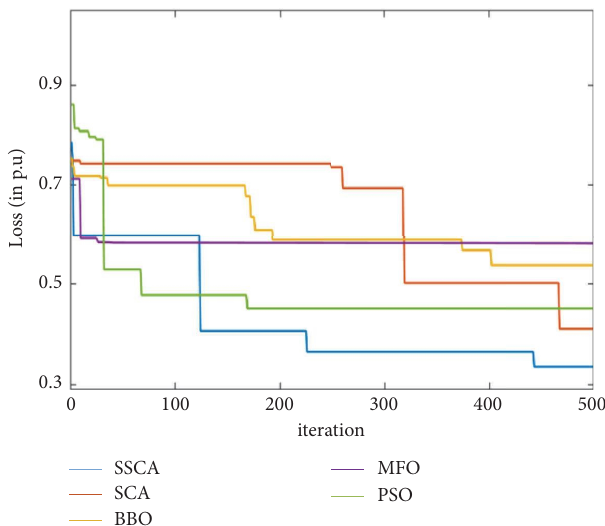
Figure 8: Loss variation in the IEEE-57 bus system at 125% loading.